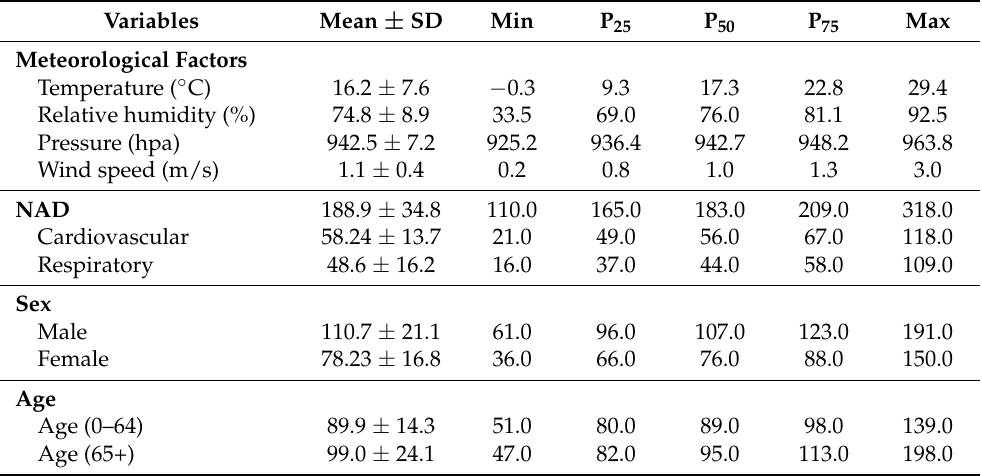
Table 1. Statistics of weather conditions and count of deaths in Chengdu, 2011–2014. NAD = non-accidental